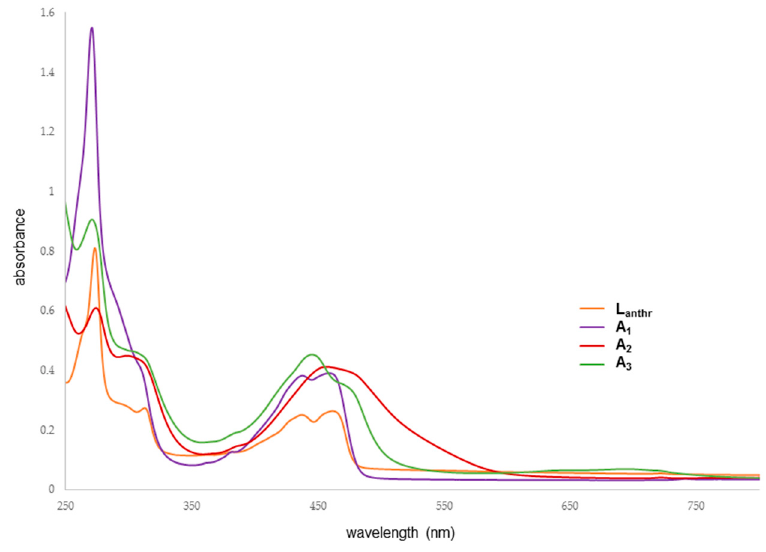
Figure 5. UV–visible spectra of L anthr , A 1 , A 2 and A 3 .